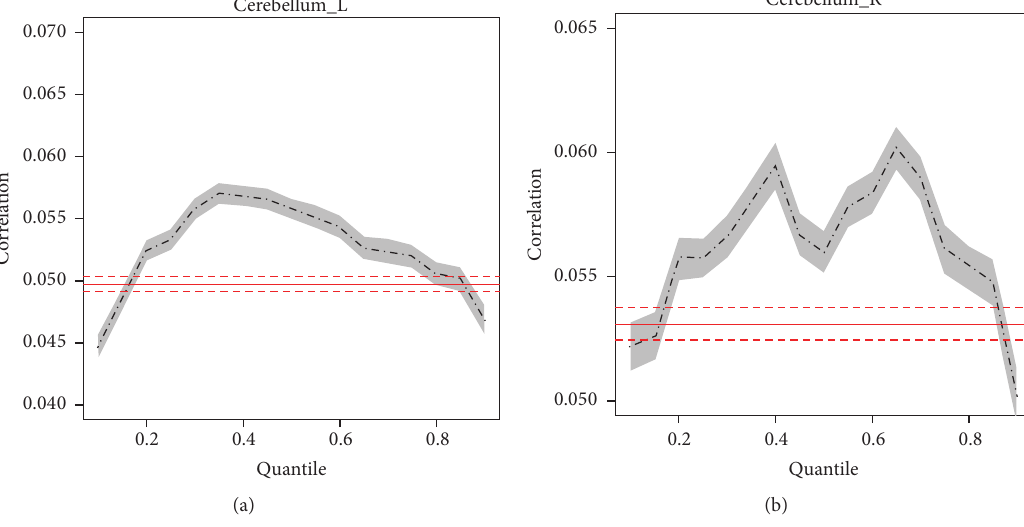
Figure 4: Results of quantile analysis from comparisons of coefficients of cross-correlation (FC) between minimal (first 100 s) and significant (last 100s) fatigue stages in bilateral cerebellum. Comparisons were made at each quantile of the distribution curve between minimal and significant fatigue conditions in bilateral cerebellum. ANOVA results were plotted in red (solid line = mean; dotted line = 95% confidential